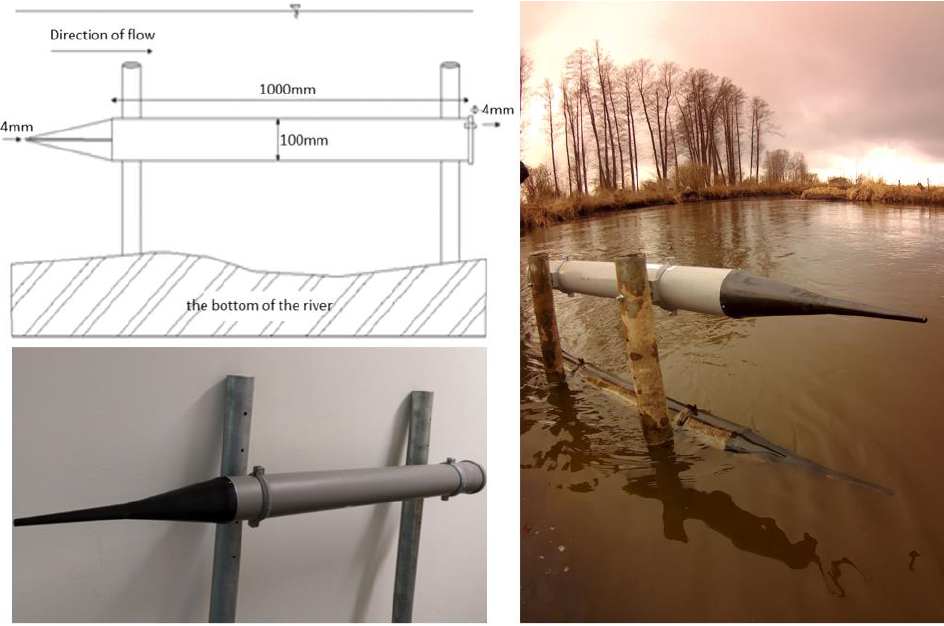
Figure 4. Suspended sediment sampler BS-2.